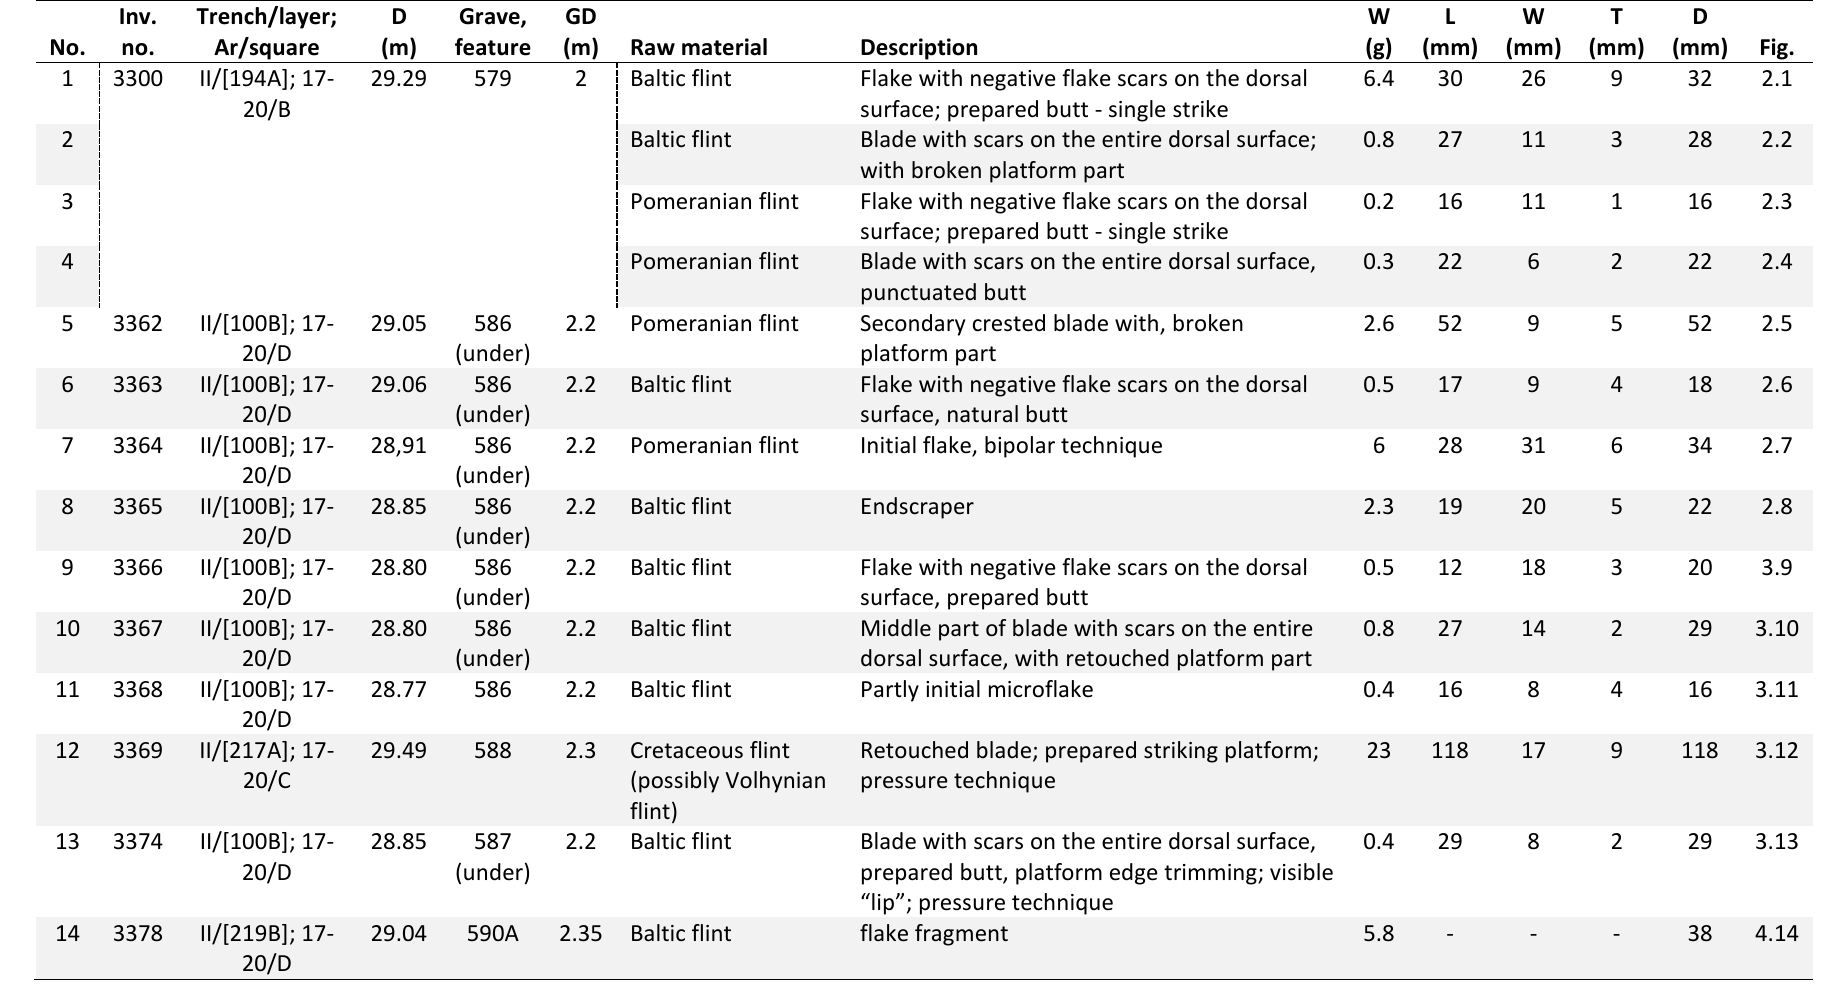
Table 1. Inventory of flint artefacts from the cemetery at Weklice, Elbląg County. Numbers correspond to Figures 2 to 4. Abbreviations: Dp - depth (m A.S.L.); GD - Grave, feature depth below ground level (m); Wt - weight (g); L - length (mm); Wd - width (mm); T - thickness (mm); Dm - diameter (mm); Fig. - figure. (Elaborated by D. H.